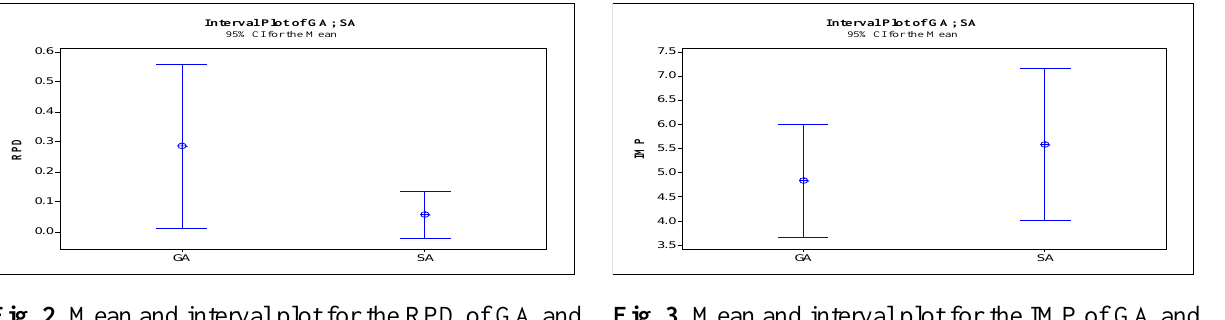
Fig. 3. Mean and interval plot for the IMP of GA and